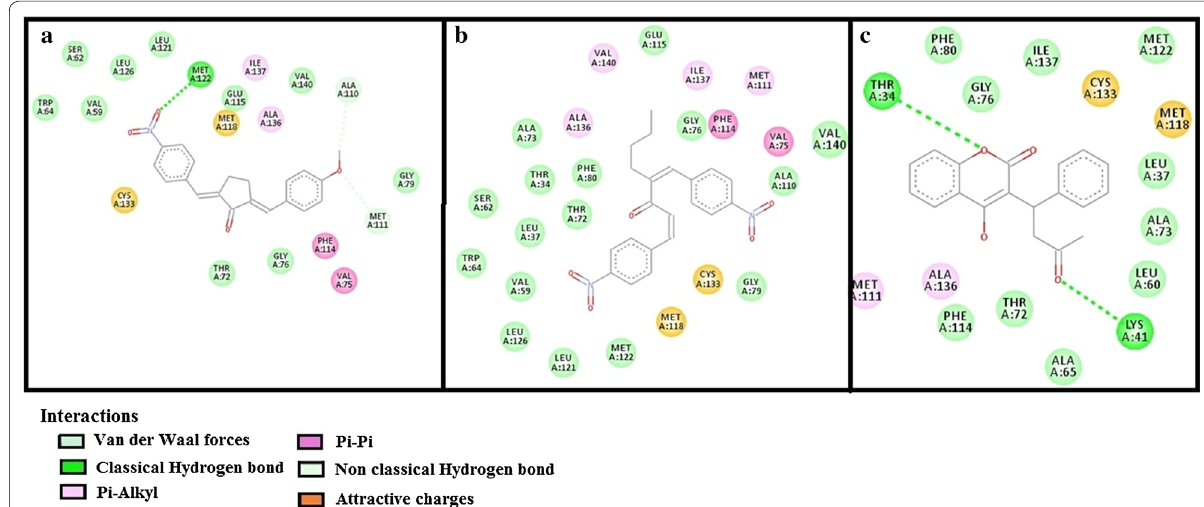
Fig. 12 a – c Represents interactions of ligands: (2 E ,5 E )‑2‑(4‑methoxybenzylidene)‑5‑(4‑nitrobenzylidene) cyclopentanone (AK‑1a), (1 E ,4 E )‑4‑(4‑nitr